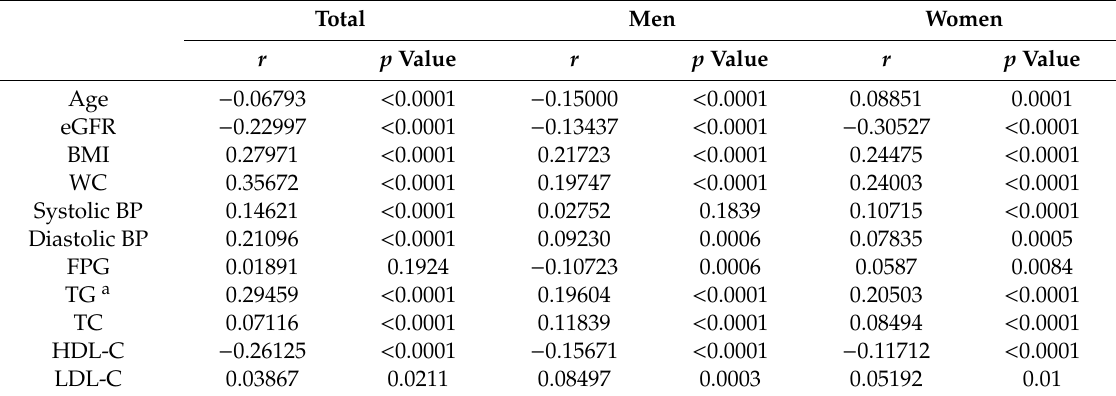
Table 2. Correlation coe ffi cients of serum uric acid levels with various anthropometric and biochemical